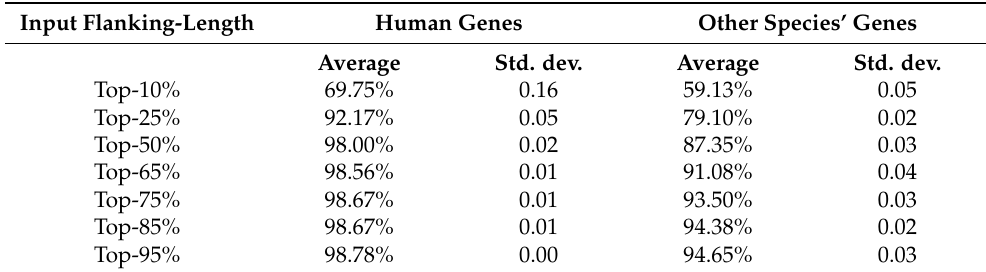
Table 6. Top- k accuracies of Deep Splicer.